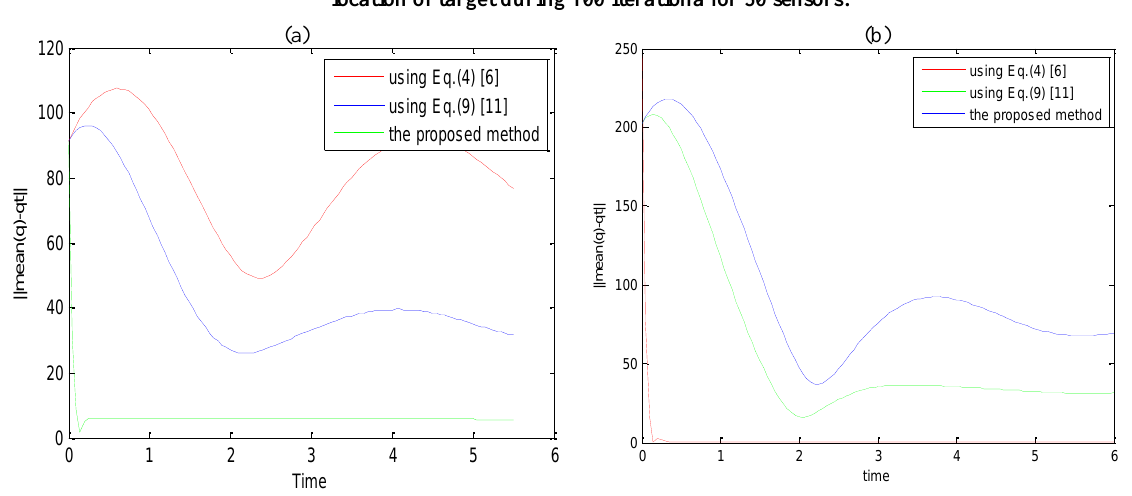
Figure 8. (a) Errors between COM of locations of robots and location of target in circular trajectory, (b) errors between COM of locations of robots and locations of two targets in semi-circular and semi-sine trajectory; all following processes for three algorithms are done on 50 sensors.